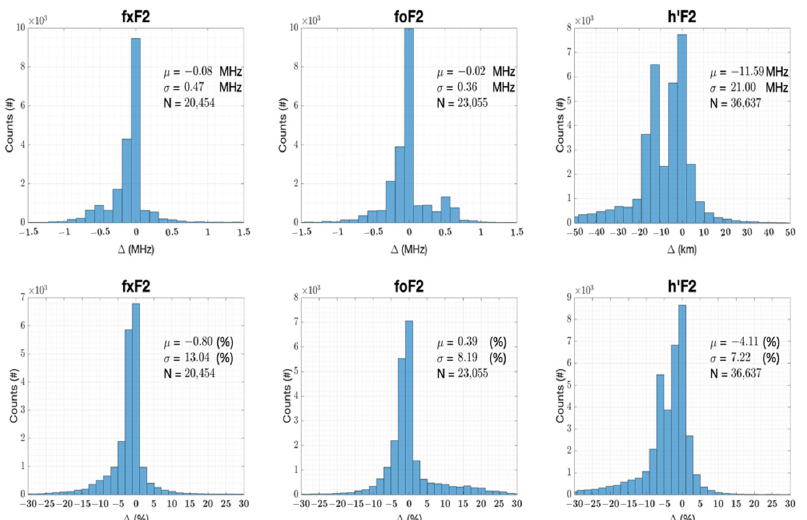
Figure 11. Histograms of the differences ( upper ) and the percentage differences ( lower ) in fxF2, foF2, and h’F2 between autoscaling and manual scaling for the data collected from 1 April 2020 to 24 March 2021, in which the difference is the autoscaling minus manual scaling, and the percentage difference is defined as PD ( % ) = ( auto − manual ) × 100/ manual .